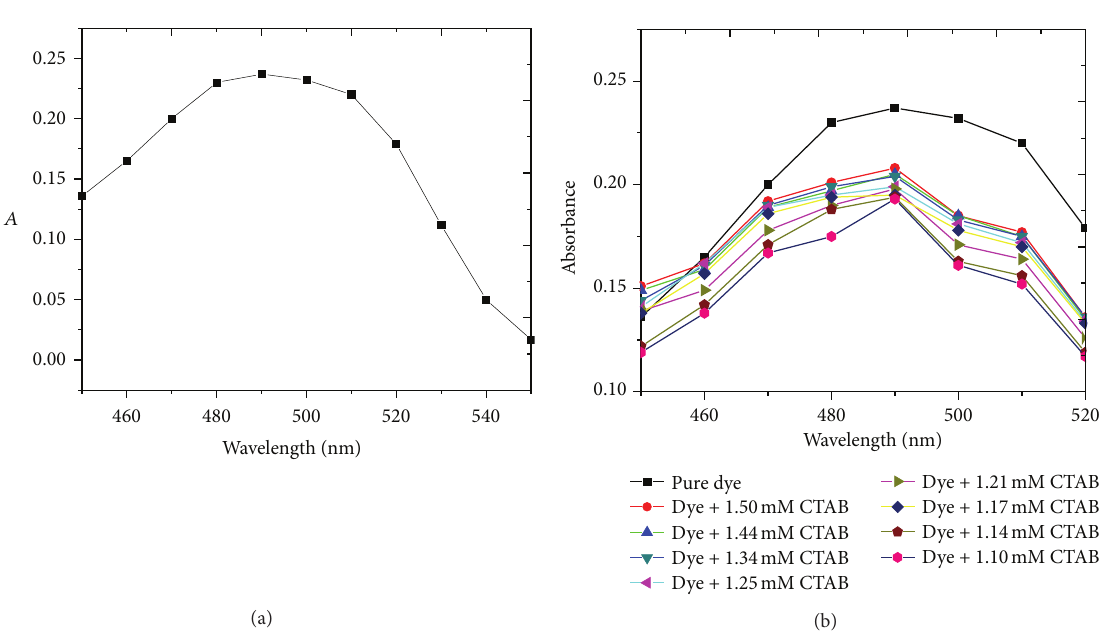
Figure 2: (a) Simple UV/visible absorption spectra of pure reactive orange 122. (b) Simple UV/visible absorption spectra of reactive orange 122 in the presence of different CTAB concentration (mol ⋅ dm −3